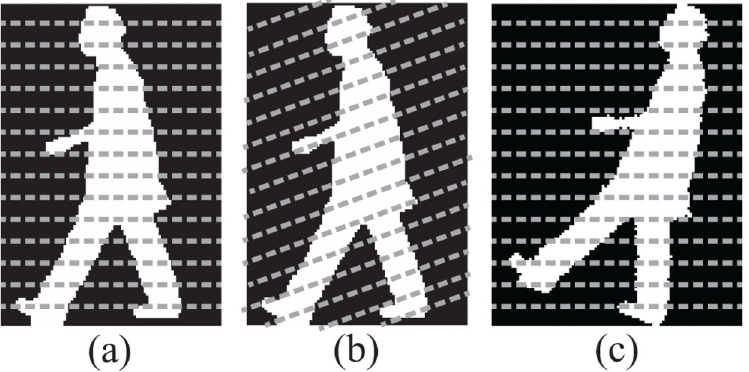
Fig 9. (a) An example original image, (b) image with scanning incident lines at 20 degree, and (c) 20 degree rotated image. (b) and (c) are equivalent from the point of view of resulting intersections of lines with